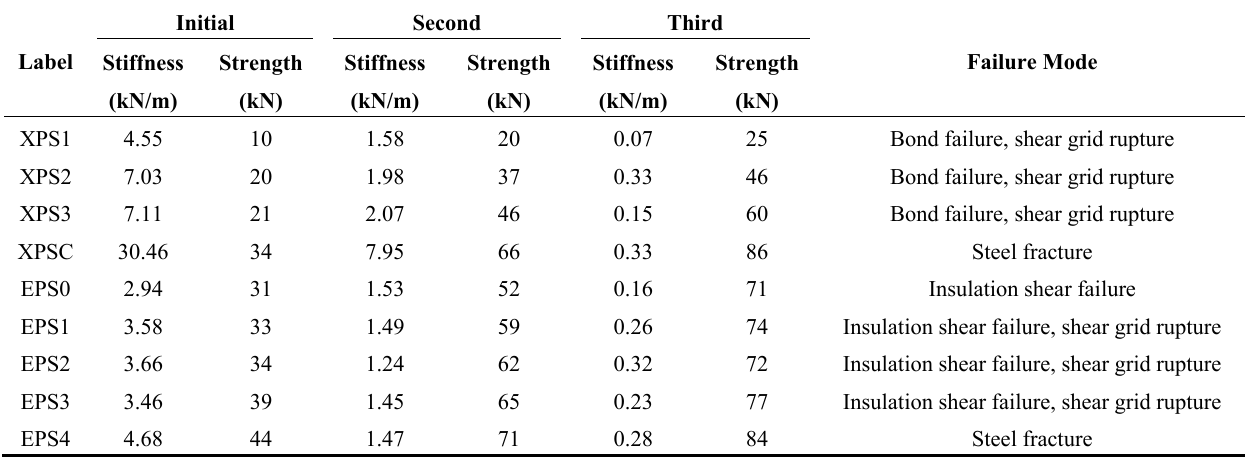
Table 3. Stiffness and strength in the three response